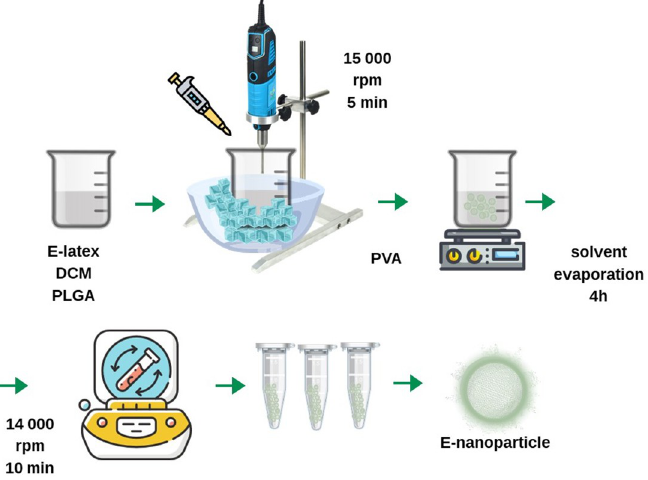
Fig 1. Steps of the preparation of blank NPs and E-NPs using the solvent evaporation method.